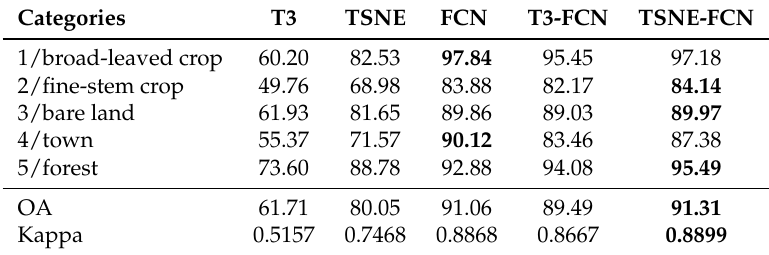
Table 4. Category accuracy (%), OA (%) and kappa coefficient of different features (classifier: SVM) on Foulum dataset. (The category with highest accuracy is shown in